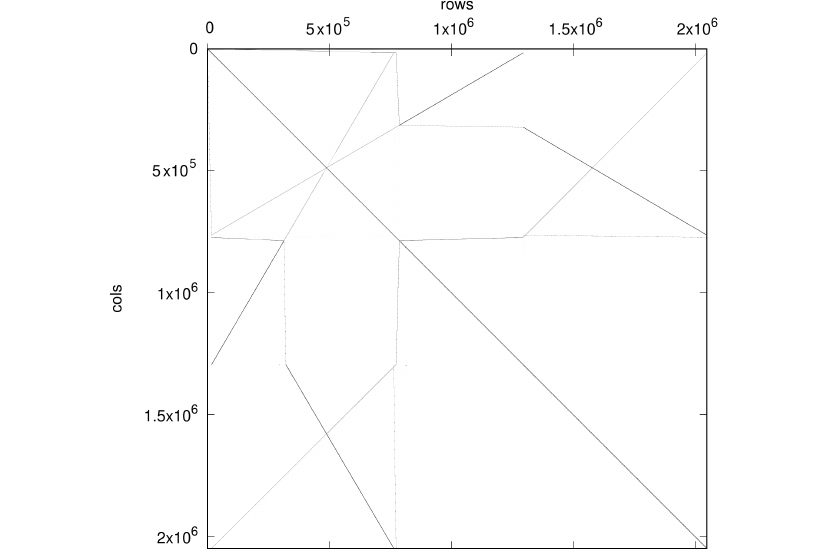
Figure 1. The visualization of the assembled sparse matrix of the SRAM Circuit. After pivoting and